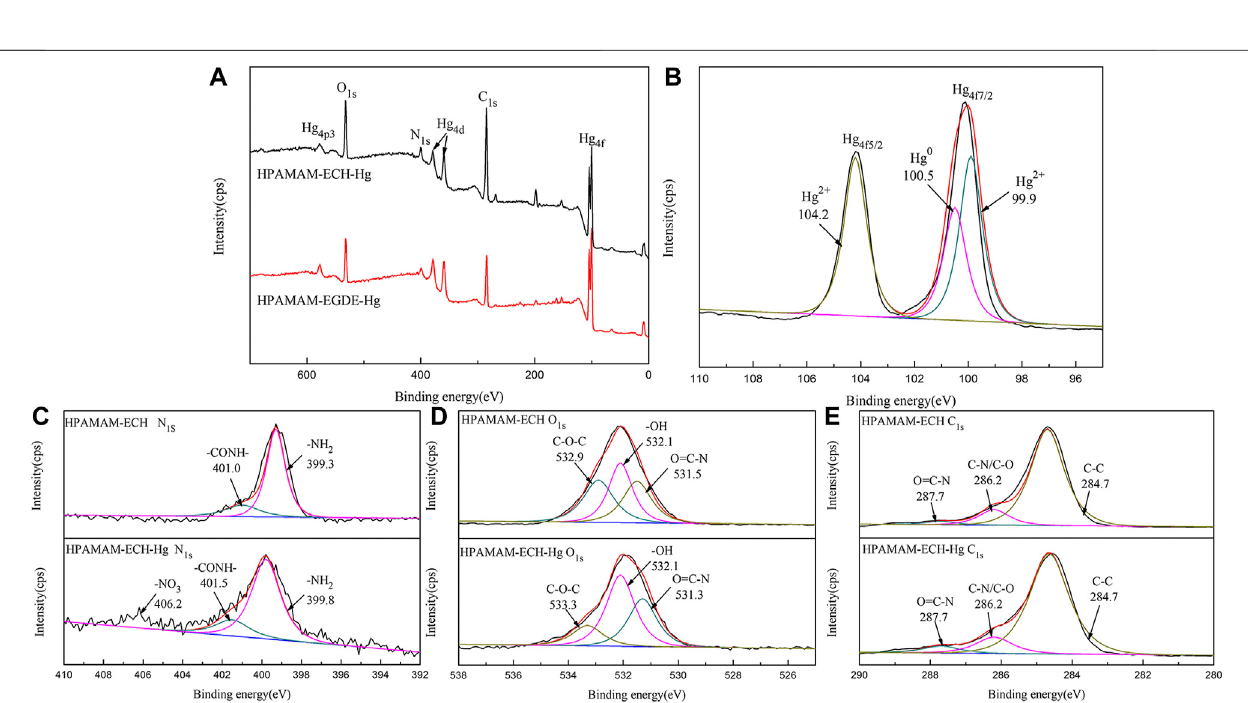
FIGURE8 |(A) Wide scan XPS spectra ofHPAMAM-ECH-3 and high-resolution XPS spectra of (B) Hg 4f , (C) N 1s , (D) O 1s , (E) C 1s ofHPAMAM-ECH-3 before and after Hg(II) adsorption.